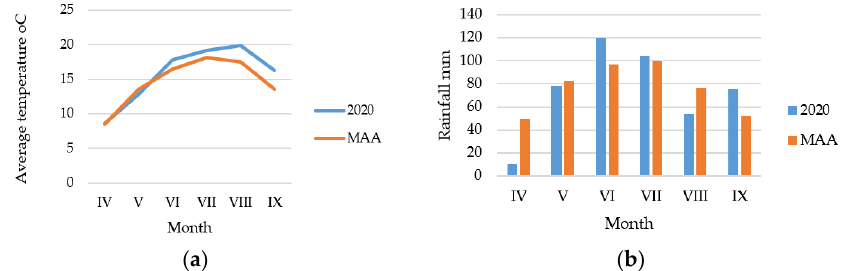
Figure 4. Average temperatures ( a ) and the amount of rainfall ( b ) during the vegetation period (MAA: multi-annual average).